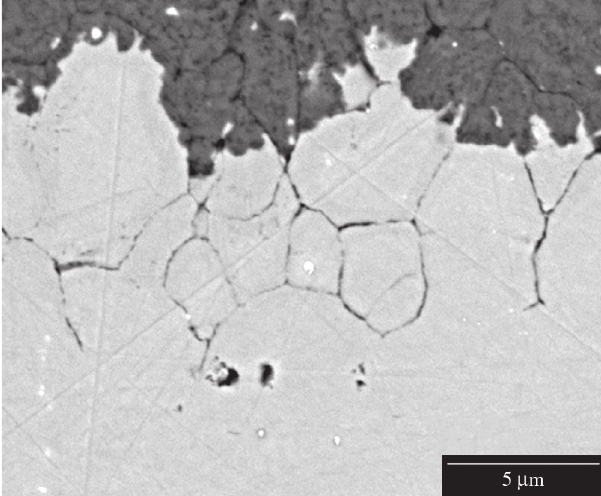
Figure 5. Oxidation of the steel 2.25Cr1Mo with two different grain sizes at 550 °C in laboratory air under isothtermal and thermal cycling conditions.